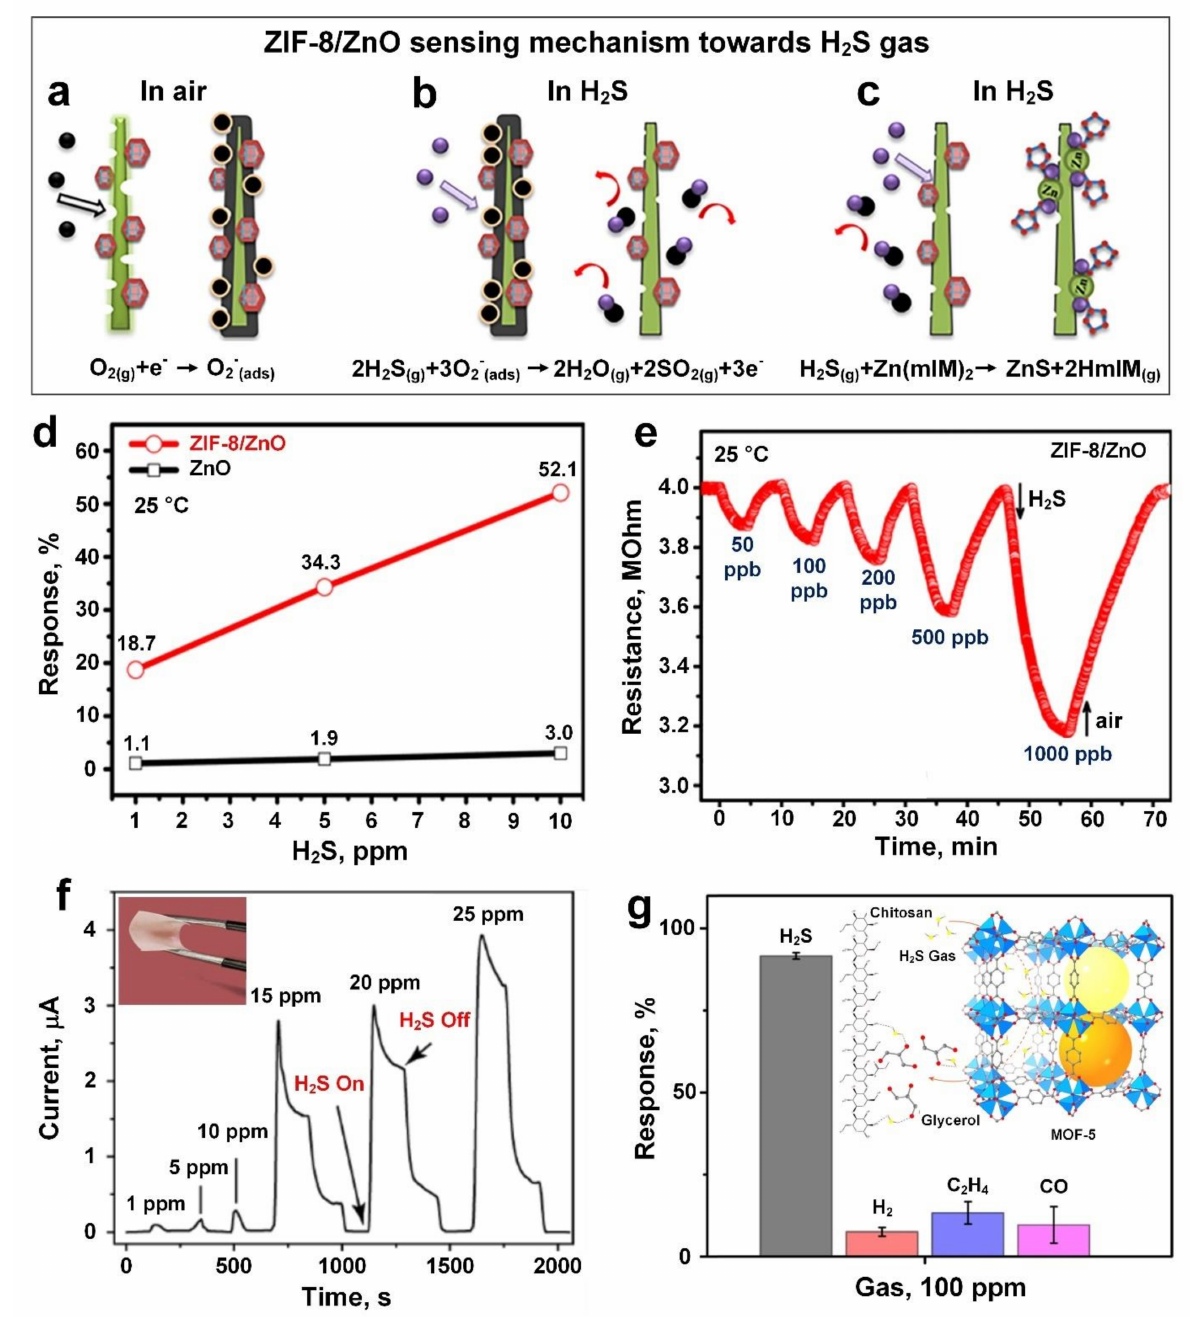
Figure 5. Schematic representation of ZIF-8/ZnO sensing mechanism towards H 2 S gas: ( a ) the surface depletion region was expanded due to more electrons were trapped by the surface chemisorbed oxygen before the sensor was explosed to H 2 S gas, the sensor exhibited a high base resistivity consequently; ( b ) when sensor was exposed to H 2 S gas, the chemisorbed oxygen would react with H 2 S molecules chemically to release the trapped electons, resulting in the reduction of depletion region and significant causing resistivity change; ( c ) H 2 S gas might interact with Zn (mLm) 2 transformed from ZIF-8 to form an intermediate product (ZnS) to further enhance the sensitivity towards H 2 S gas. ( d ) The response of ZnO and ZIF-8/ZnO toward 1, 5 and 10 ppm of H 2 S gas at 25 ◦ C. ( e ) The dynamic resistance curves of ZIF-8/ZnO against H 2 S gas at ppb-level concentration. Reproduced with permission from [94] Elsevier, 2019. ( f ) The electrical current variation of MOF-5/CS/IL membrane against H 2 S gas at different concentrations, and the flexibility demonstration of MOF-5/CS/IL membrane as inset. ( g ) The high cross-selectivity of MOF-5/CS/IL membrane towards H 2 S compared with H 2 , C 2 H 4 and CO gases, and the possible sensing mechanism for the outstanding H 2 S gas response. Reproduced with permission from [95] American Chemical Society,